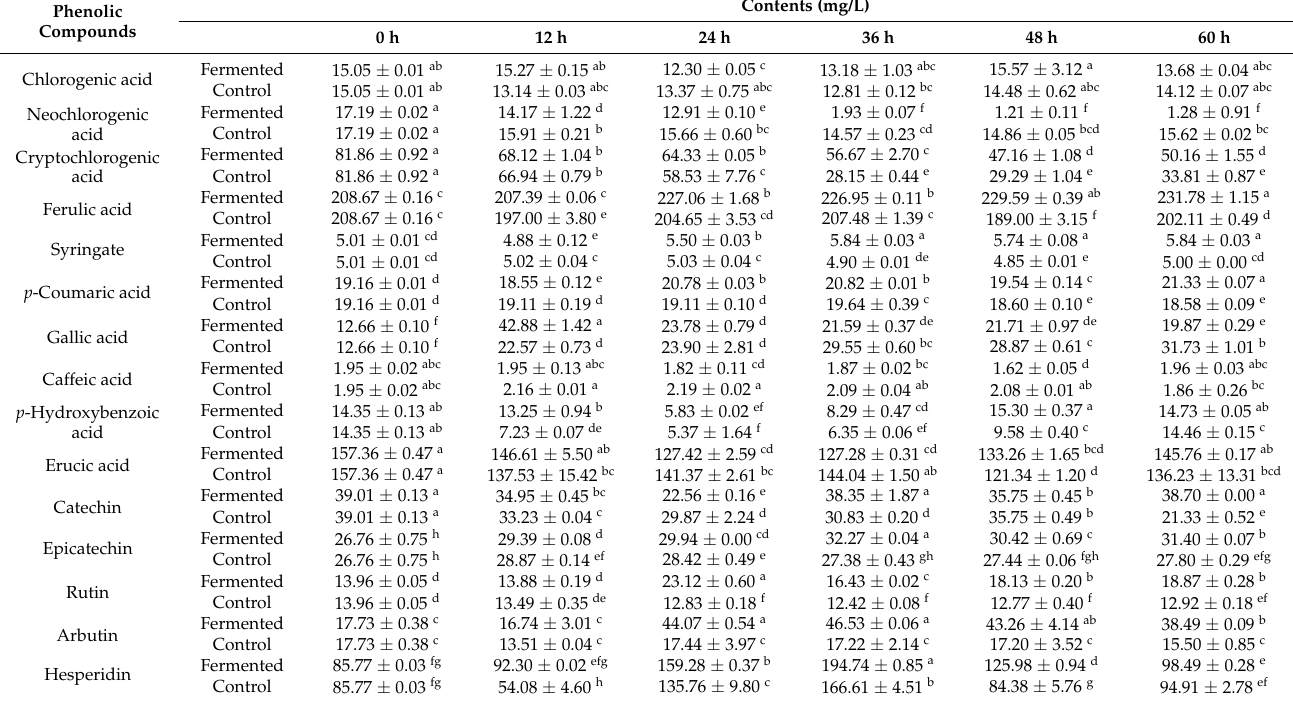
Table 2. Phenolic compounds of fermented and control lemon